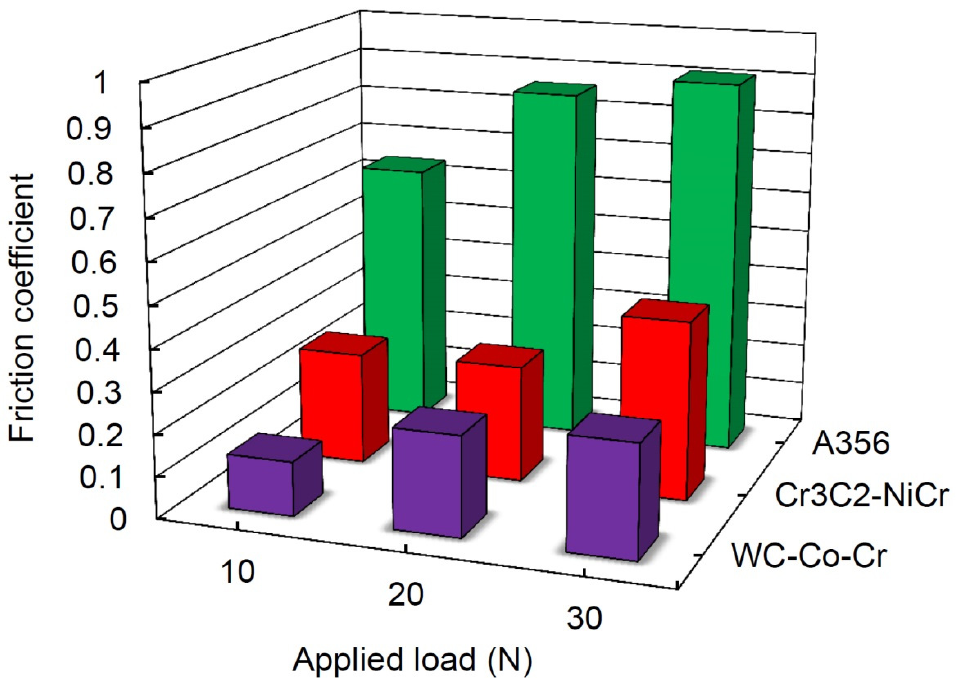
Figure 10. Comparison between average friction coefficient of A356 substrate, and Cr 3 C 2 -NiCr and WC-Co-Cr coatings at different applied loads.